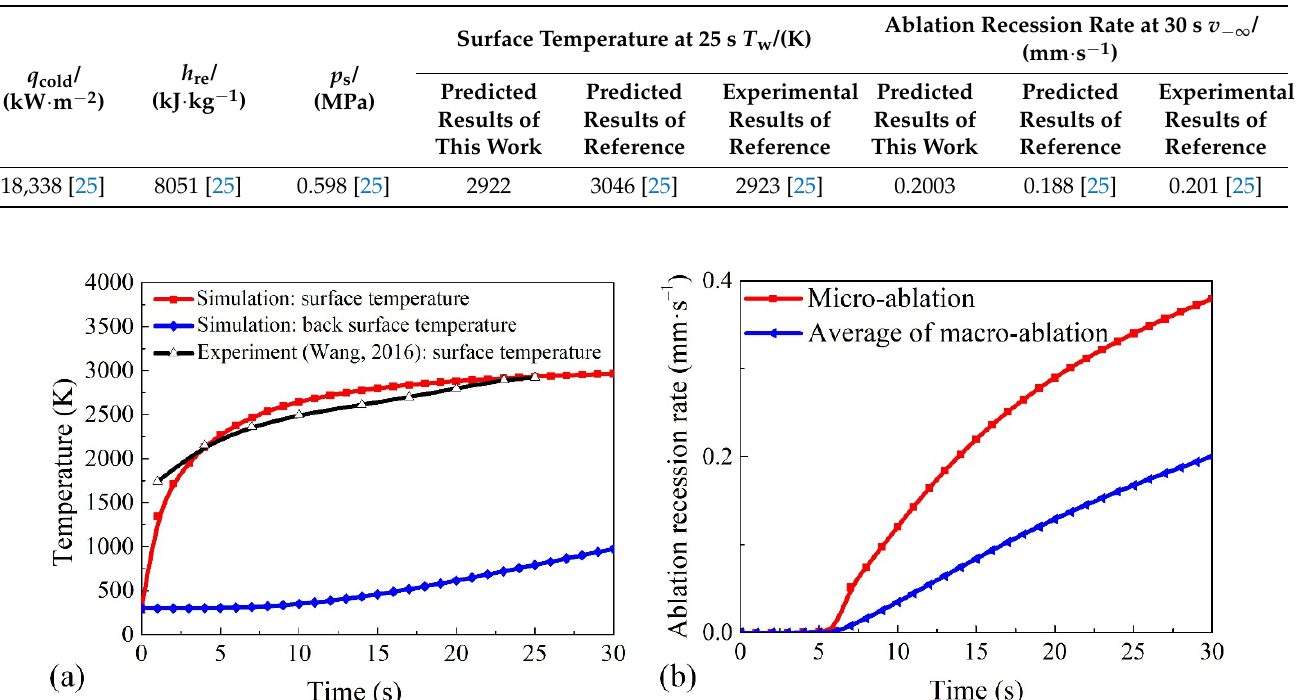
Figure 6. ( a ) Ablation temperature (Reprinted/adapted with permission from Ref. [25]. 2016, Elsevier.) and ( b ) ablation recession rate plotted against the ablation time.